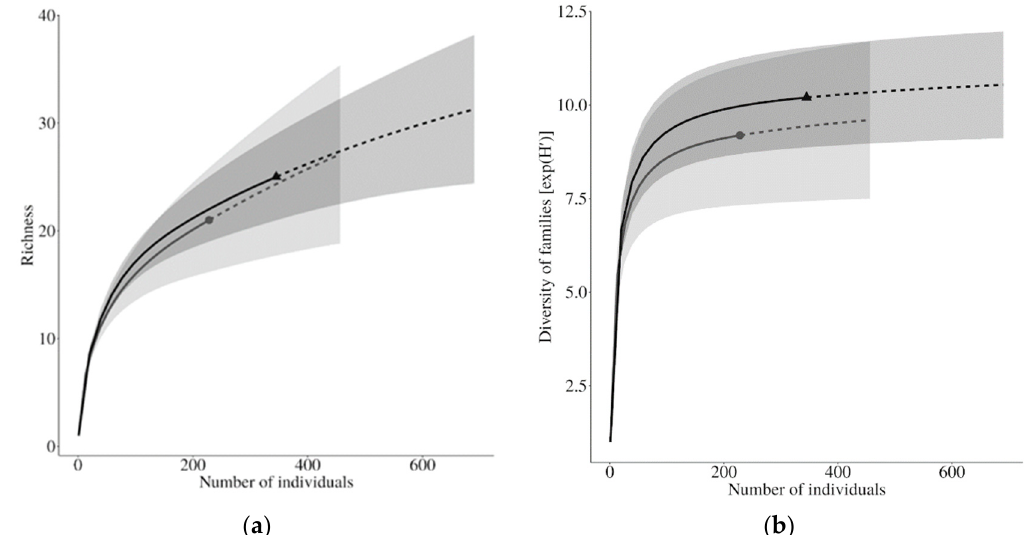
Figure 3. Sample-size-based rarefaction and extrapolation curves for the richness ( a ) and exponential of the Shannon entropy ( b ) of arachnid species in burned (grey circles) and unburned areas (black triangles). Symbols denote the observed values and shaded areas show the 95% confidence interval. Solid and dashed lines represent the interpolation and extrapolation component of the analysis, respectively.